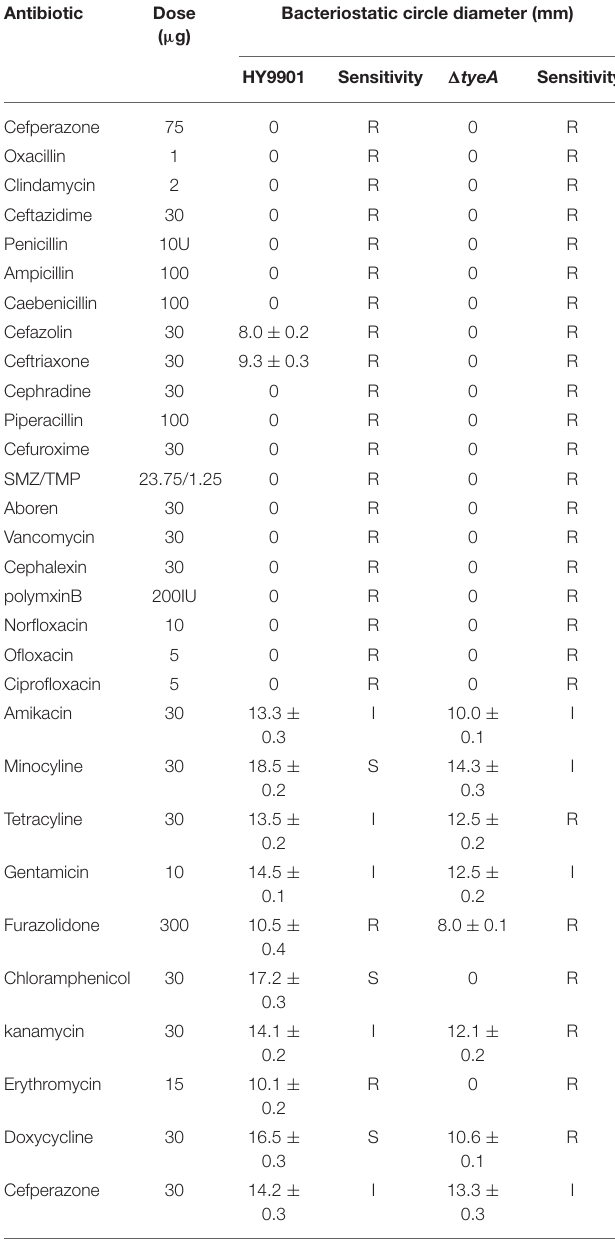
to grouper, the HY9901 1 hop mutant showed no difference